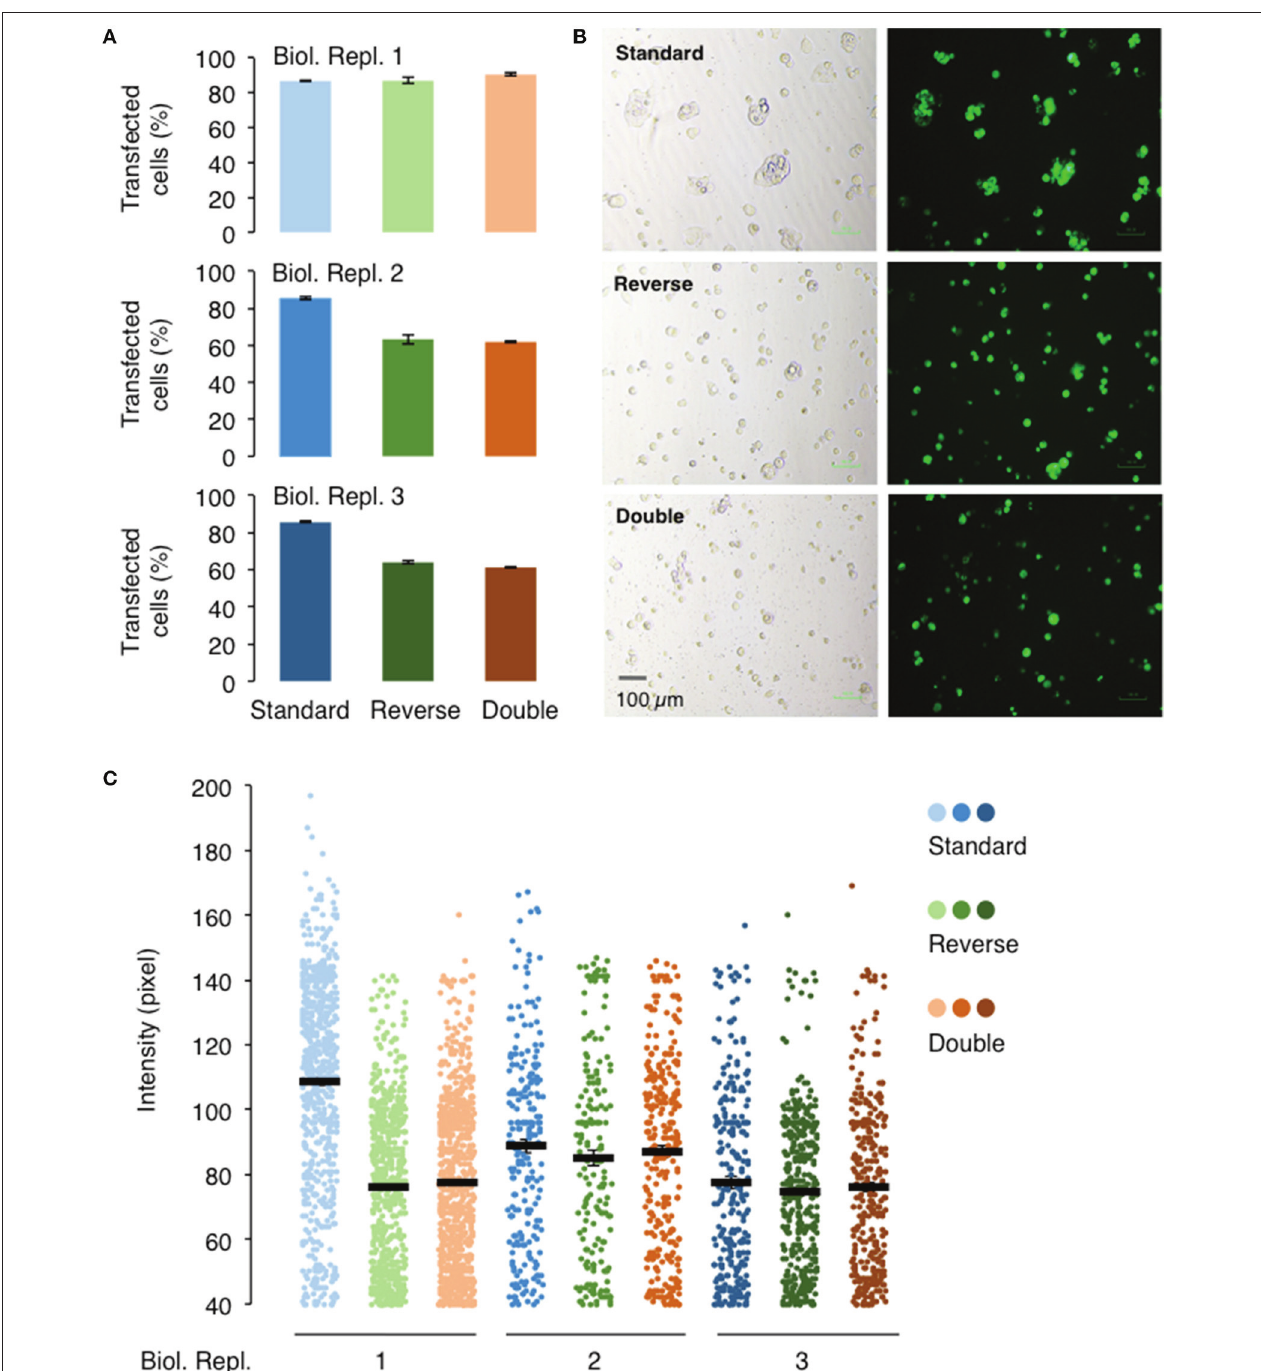
FIGURE 4 | Effect of different transfection methods on the transfection and expression efficiencies of AtGORK-EmGFP in HEK-293 cells. HEK-293 cells transfected with AtGORK-EmGFP were used to examine the performance of different transfection format: “standard,” “reverse,” and “double” (see Section Procedure for definition) using the Lipofectamine ® 3000 reagent. The “standard” transfection method outperforms both the “reverse” and “double” transfection format respectively, in 2 out of 3 biological repeats in terms of transfection efficiency (A,B). The “standard” transfection protocol yields higher protein expression levels in only 1 biological replicate but yield comparable expression levels to the other transfection methods in replicates 2 and 3 (C) . A typical 20 × HEK cell image contains 2560 × 1920 pixels and is converted to an 8-bit byte image that is on a scale of 0–255 using ImageJ. The lower limit cut-off representing appreciable and above background fluorescence, was set at 10 pixels for 40 pixels. Transfection efficiency and protein expression of more than 100 cells in each viewing field were analyzed (see Section Procedure for analysis).